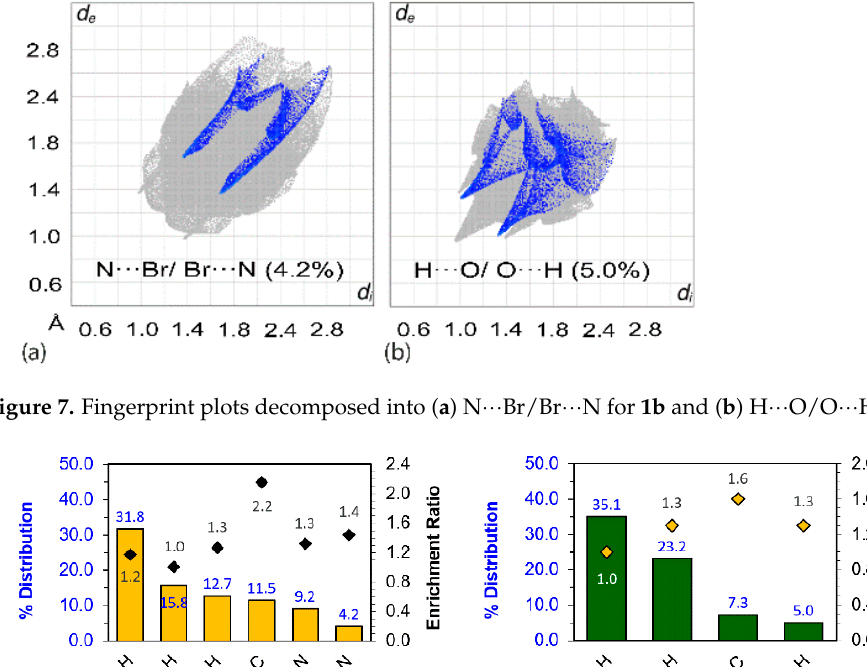
Figure 7. Fingerprint plots decomposed into ( a ) N···Br/Br···N for 1b and ( b ) H···O/O···H for 1c .